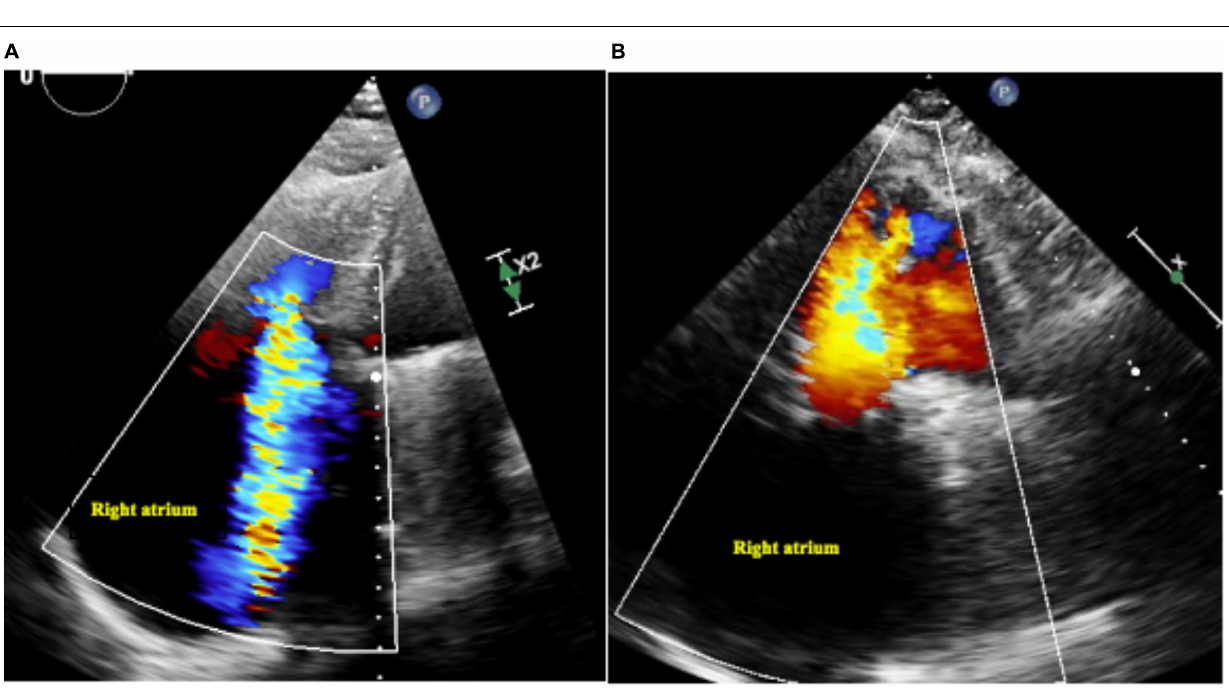
FIGURE 3 | Pre and post-surgery Doppler echocardiograpy. (A) Preoperative cardiac ultrasound showing a large back flow from the right ventricle to the right atrium; (B) postoperative cardiac ultrasound showing no back-flow from the right ventricle to the right